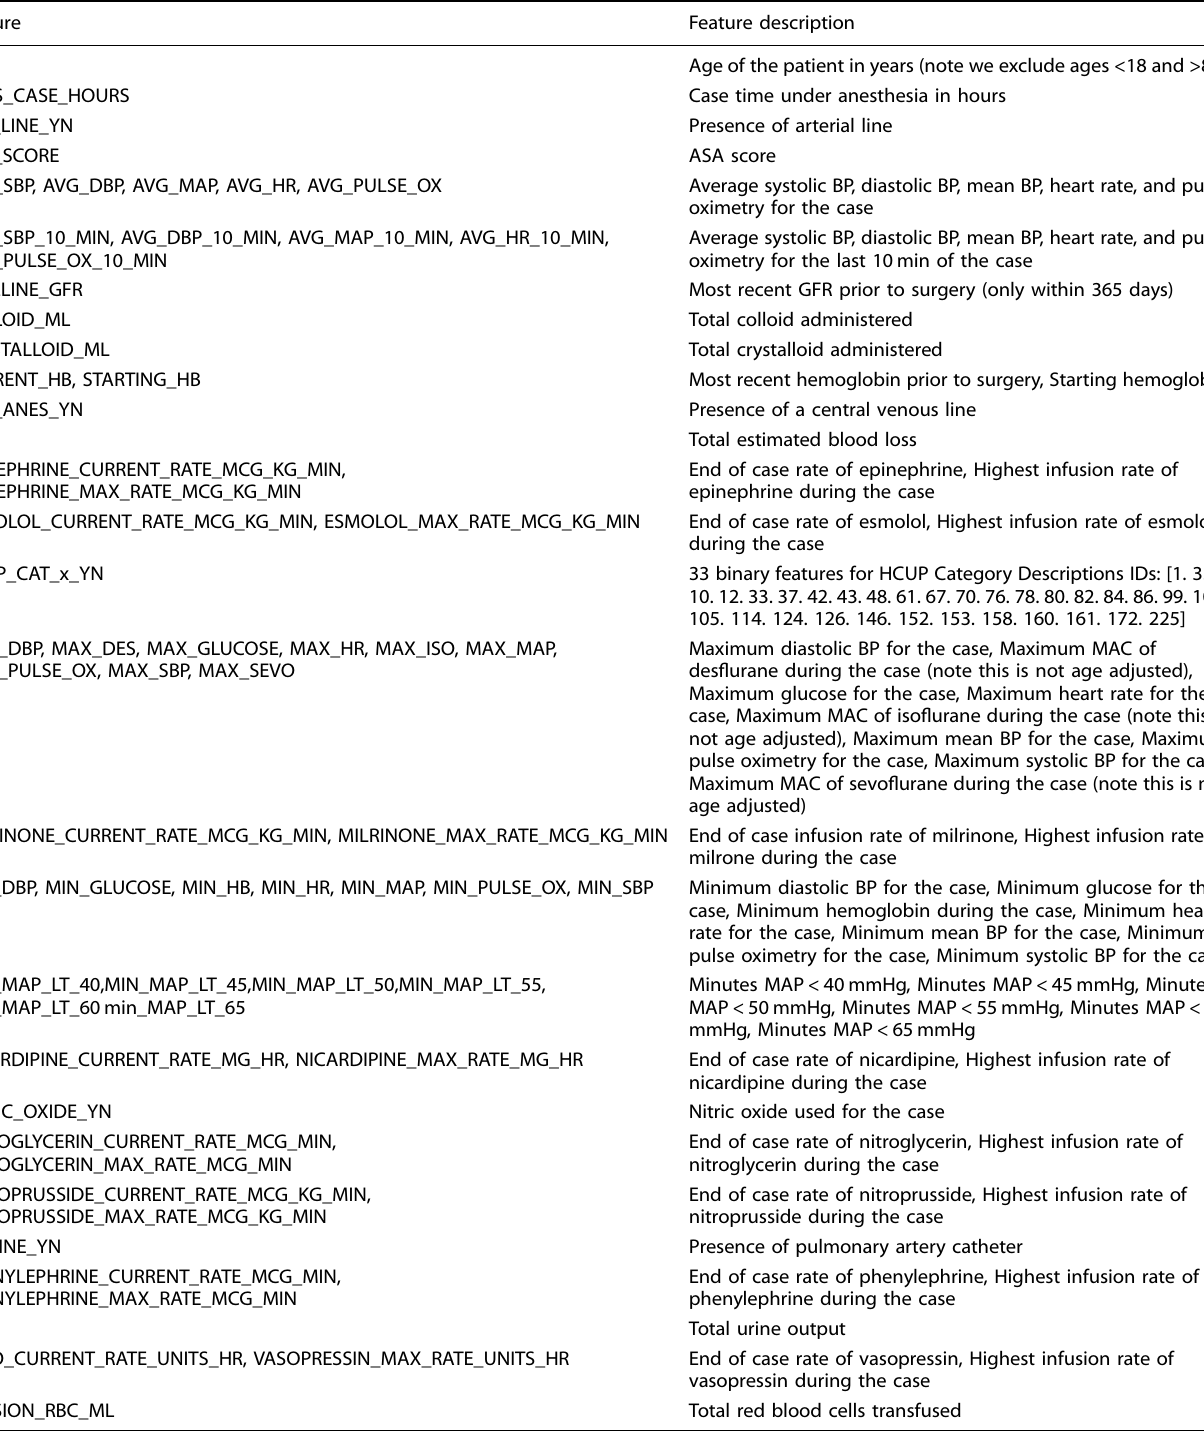
Table 5. Description of model input